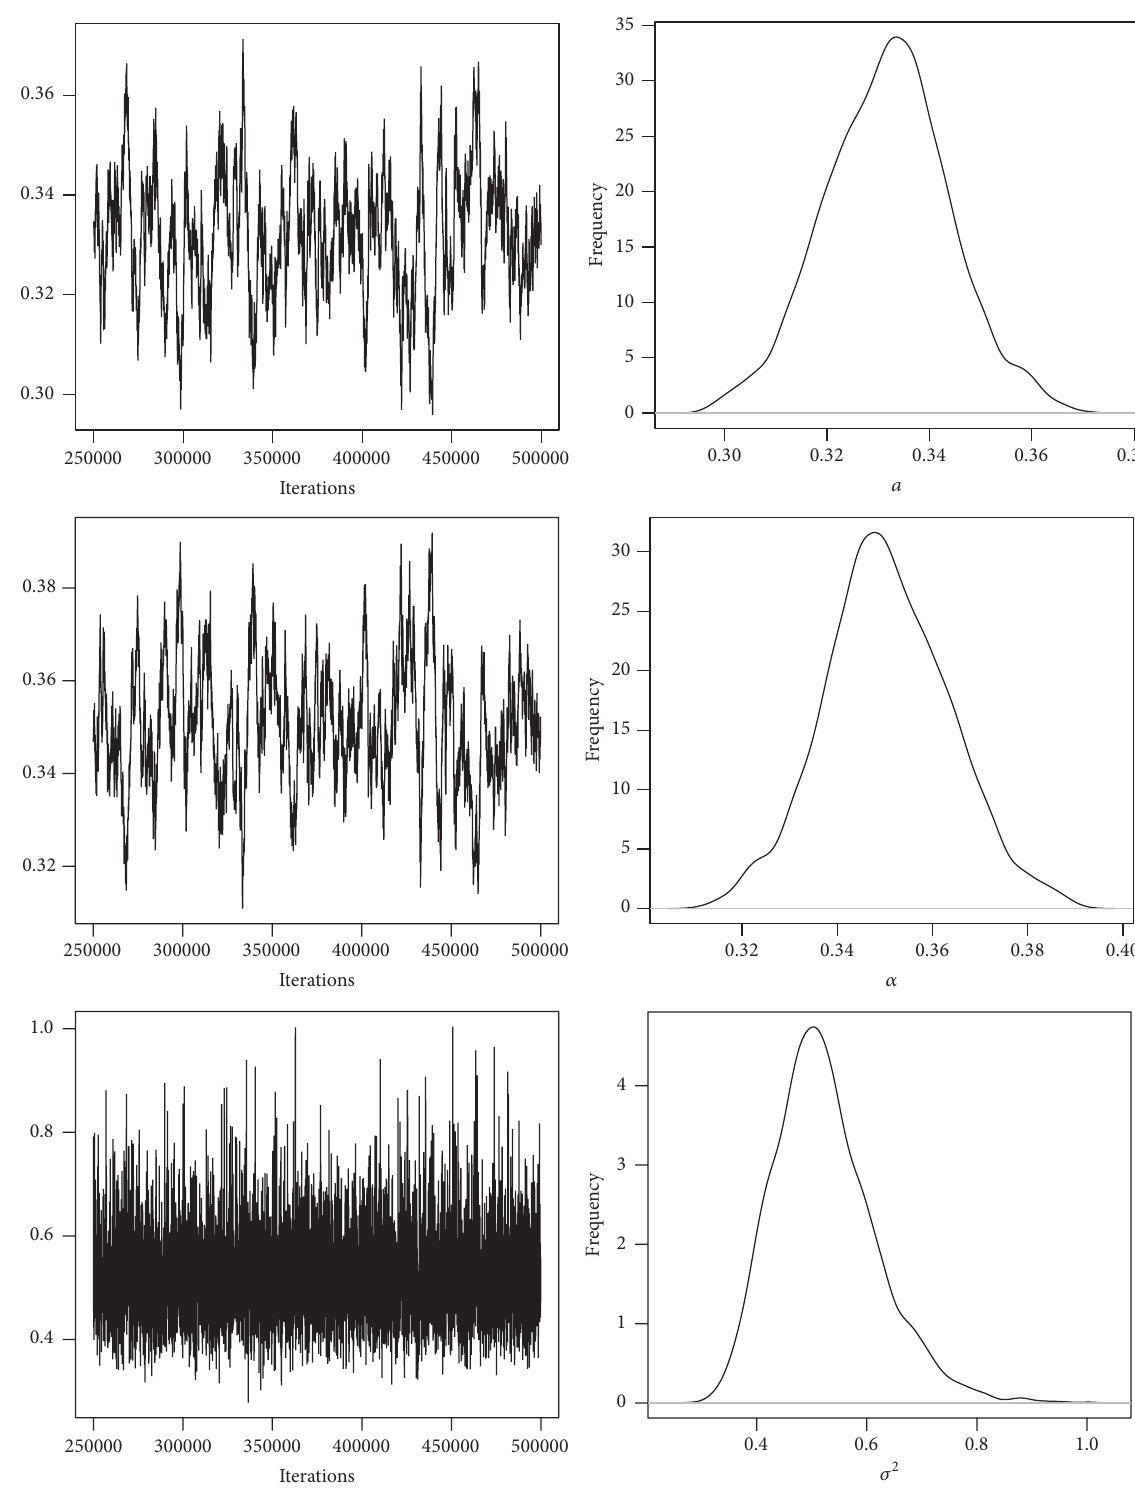
Figure 1: Trace and estimated posterior densities of 𝑎 , 𝛼 , and 𝜎 2